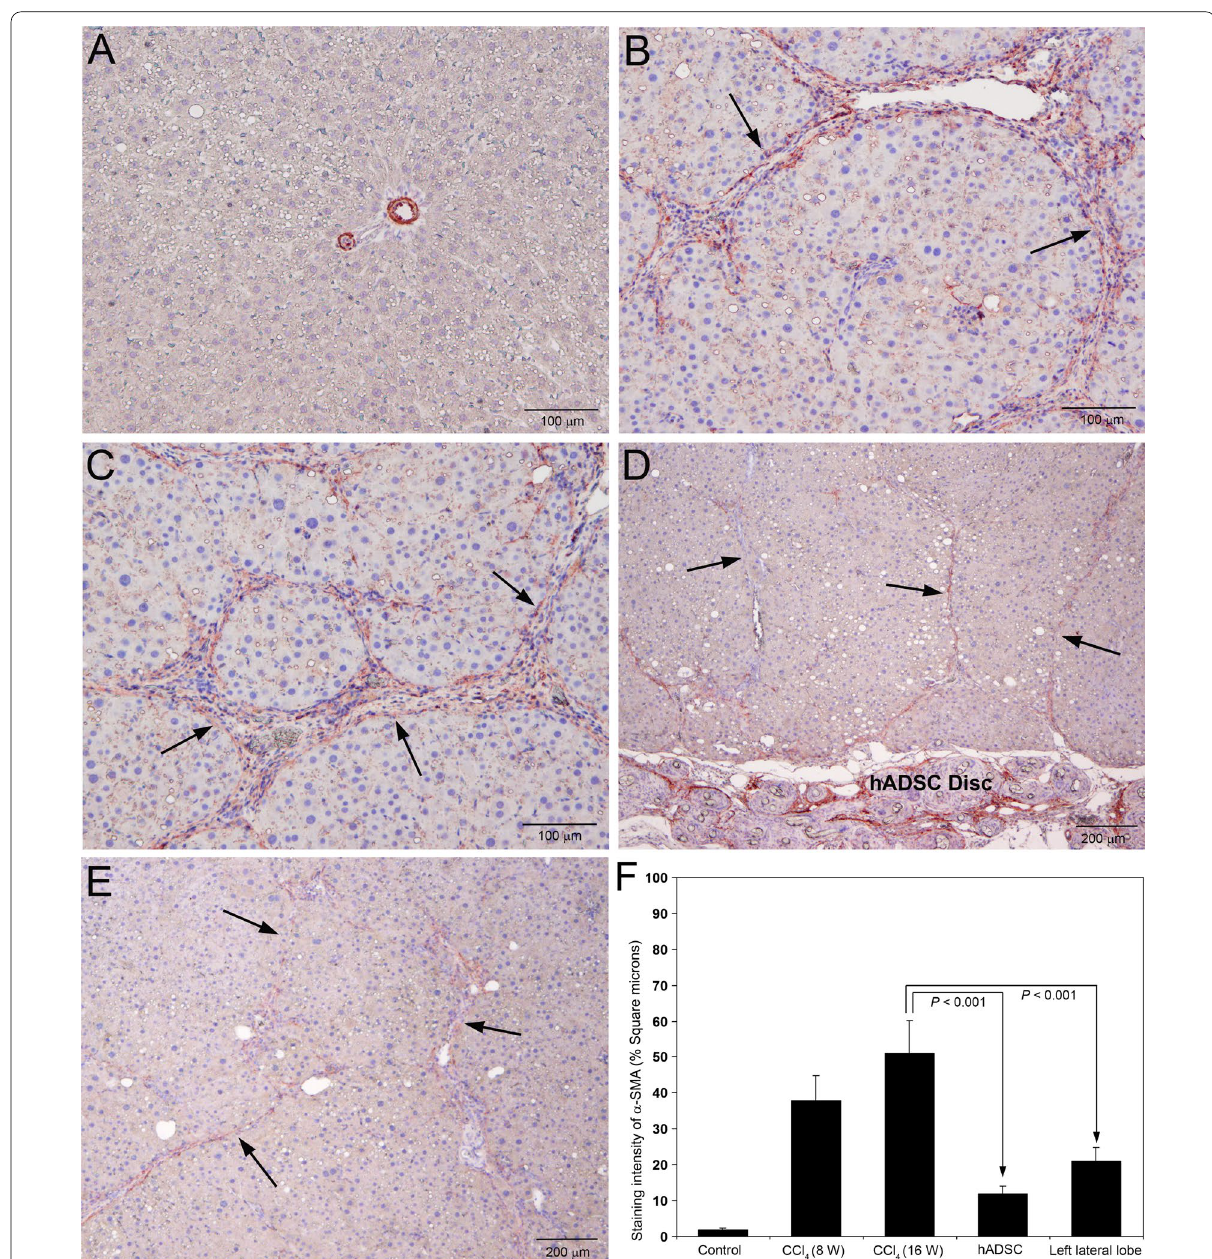
Fig. 6 Immunohistochemical staining of α-smooth muscle actin (α-SMA) in rat liver sections following serial administrations of CCl 4 and after treatment with hADSC disc. A Staining for α-SMA was completely absent in the control livers treated with olive oil for 16 weeks. B Remarkable staining for α-SMA was present in the fibrotic areas of rat livers treated with CCl 4 for 8 weeks (arrows). C At 16th week of CCl 4 administration, enormous and obvious staining for α-SMA was present in the periphery of thick collagen fibers (arrows). D Treatment with hADSC disc for 8 weeks demonstrated significant reduction in staining for α-SMA in the fibrotic zone (arrows). The implanted hADSC disc is clearly visible at the bottom portion of the image. E Marked decrease in staining of α-SMA in the left lateral lobe, where the right lateral lobe is implanted with hADSC disc (arrows). A – C Original magnification, 100. D , E Original magnification, 40. F Quantification of the staining intensity of α-SMA as square microns. × × The intensity of α-SMA staining was quantified using Image-Pro Discovery software. The data are mean S.D. of 10 randomly selected microscopic ± fields from five rats per